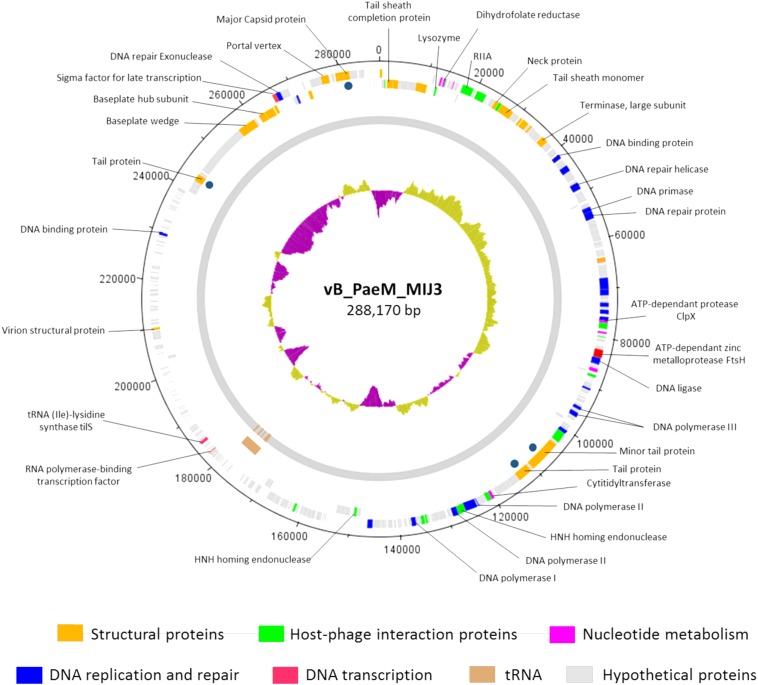
Circular genomic map of bacteriophage MIJ3. Phage MIJ3 possesses proteins involved in virion structure (orange), host–phage interaction (green), nucleotide metabolism (purple), DNA replication and repair (blue), and DNA transcription (pink). It also encodes host-like proteins such as FtsH (red) and tilS. There are 12 tRNAs in the genome of MIJ3 (brown). Other proteins with unknown functions are marked with gray. Dark blue dots indicate structural proteins confirmed by ESI-MS/MS. The map was generated using Artemis version 17.0.1.